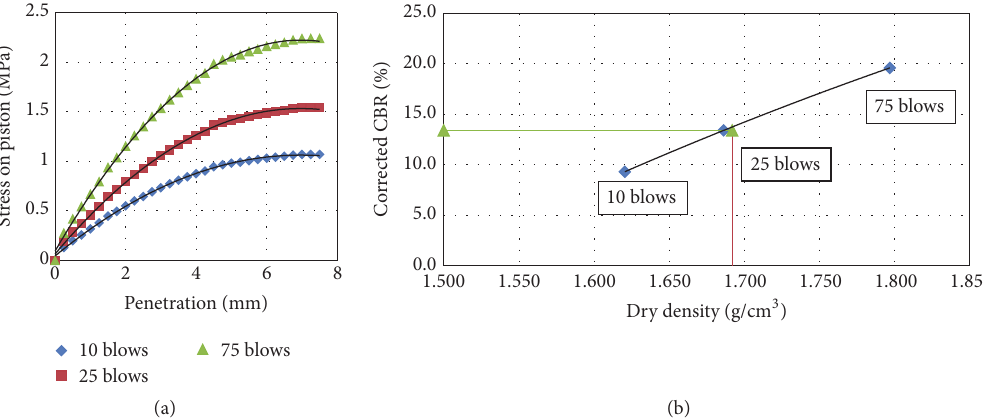
Figure 10: (a) Relationship between resistance and penetration for soil with 15% FSSA additives. (b) CBR value for soil with 15% FSSA additives.